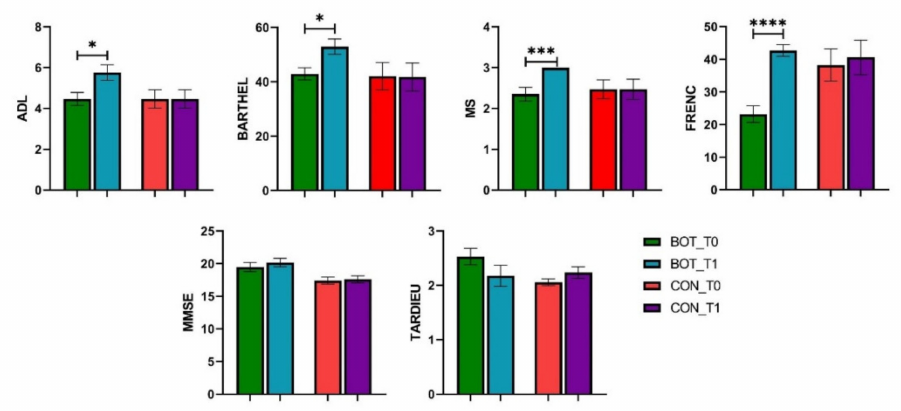
Figure 2. Differences between baseline and study end for BOT and CON groups (mean and SEM). *, p-value < 0.05; **, p-value < 0.001; ***, p-value <